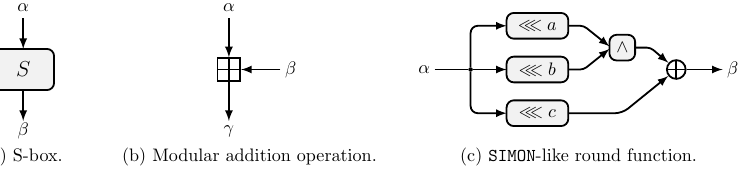
Figure 2: Non-linear